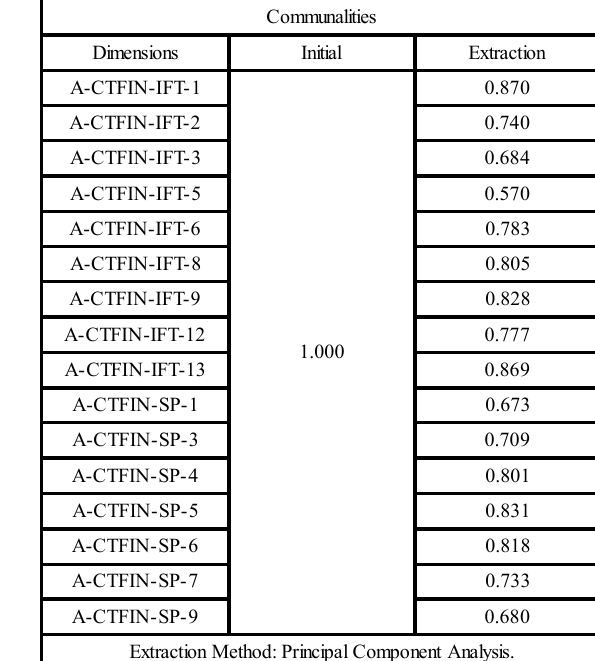
TABLE 10. EXTRACTION METHOD: PRINCIPAL COMPONENT ANALYSIS (TOTAL VARIANCE